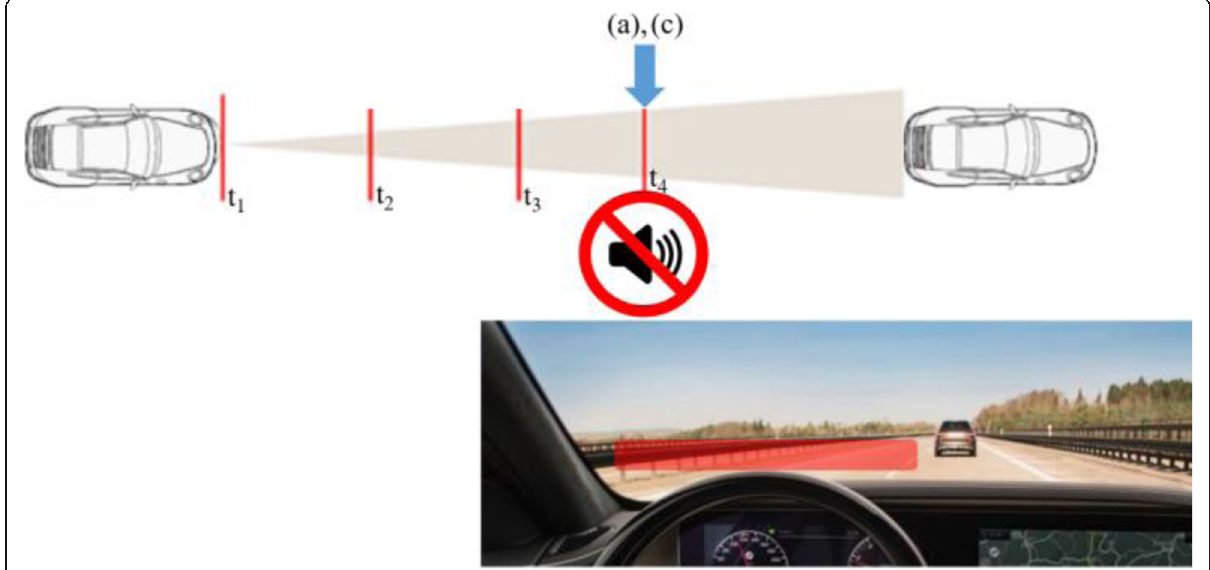
Fig. 3 Highly attentive mode; ( a , t 4 ) optical HUD warning; ( c , t 4 ) partial